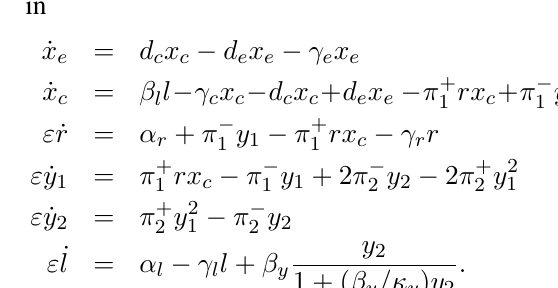
is for simplicity only assumed to take place in the state of a single LuxR, not within the LuxR-AHL complex and not within the